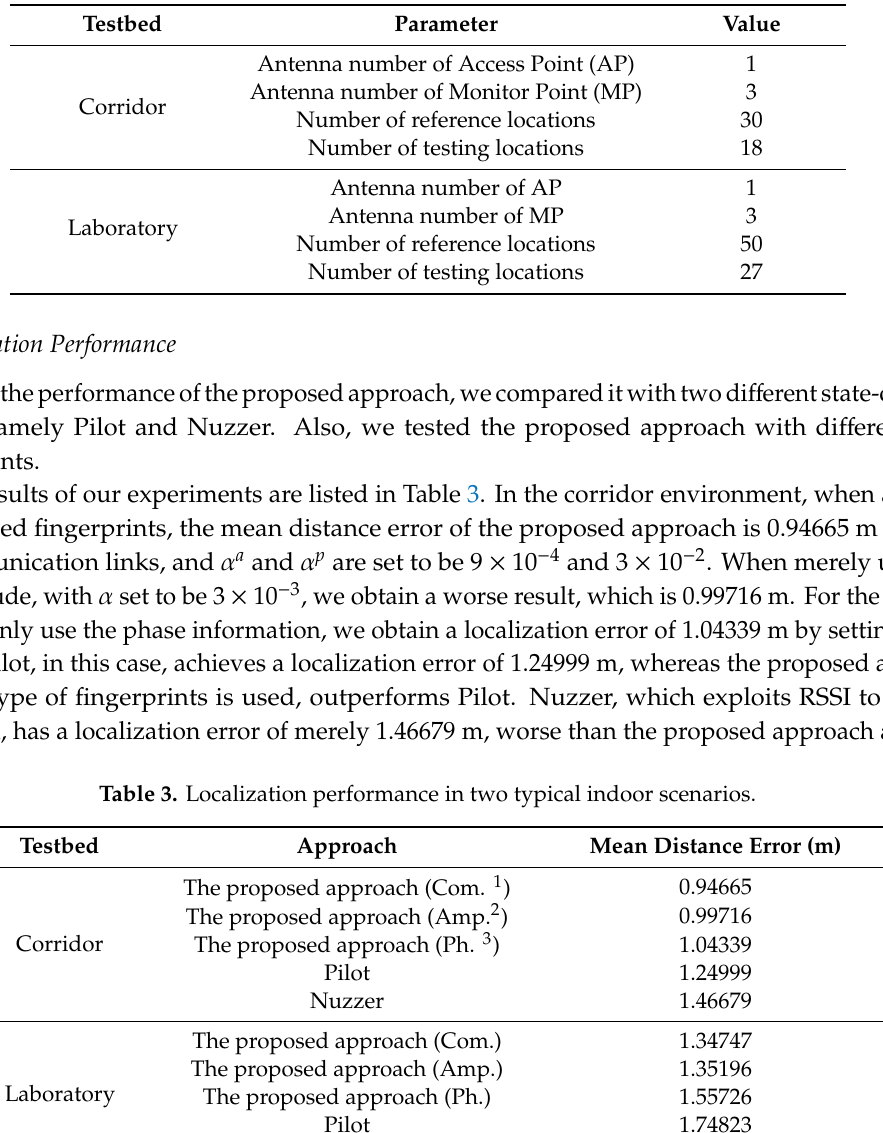
Table 2. Configurations of the two indoor scenarios.